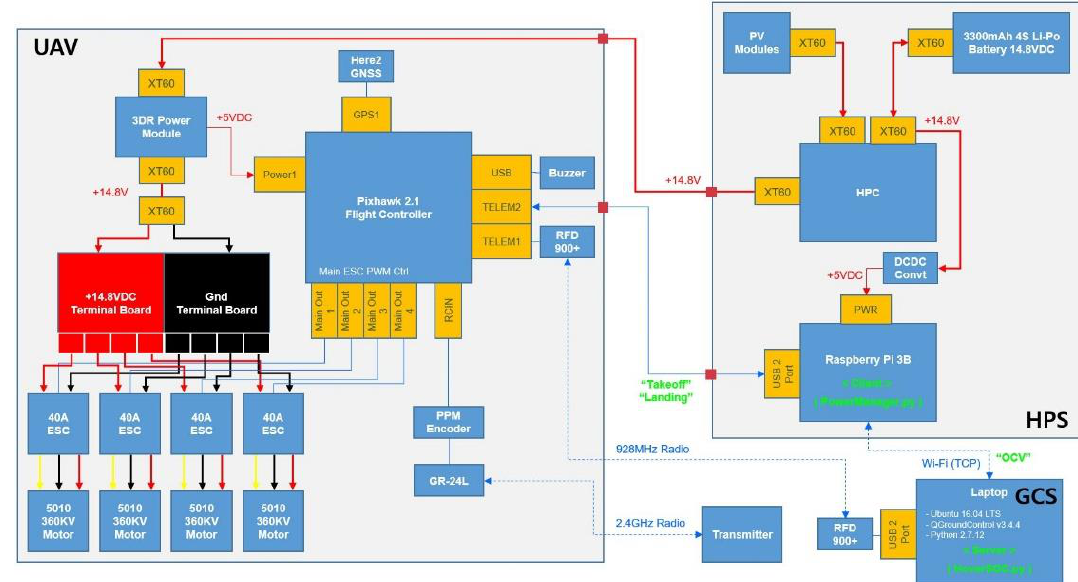
Figure 1. System overview of unmanned aerial vehicle (UAV), hybrid power system (HPS), and ground control system (GCS).